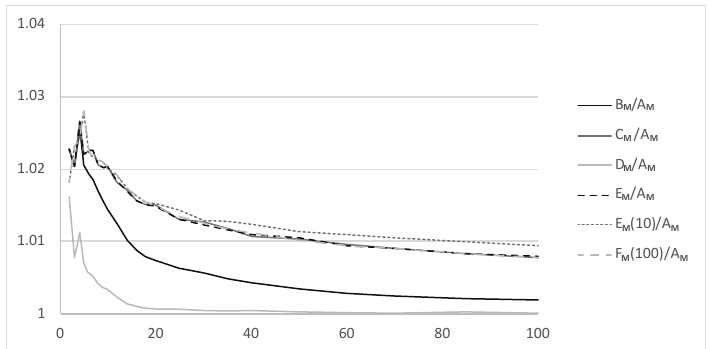
Figure 4. This plot depicts the quotients with A M for the instances from the first subset of the third dataset (see Section 4.1) corresponding to k = 3. The x axis represents the size of each partition n , while the y axis represents the quotient. We can see that with larger n , E M (10) outperforms all other algorithms, while C M , E M , and F M (100) perform similarly.